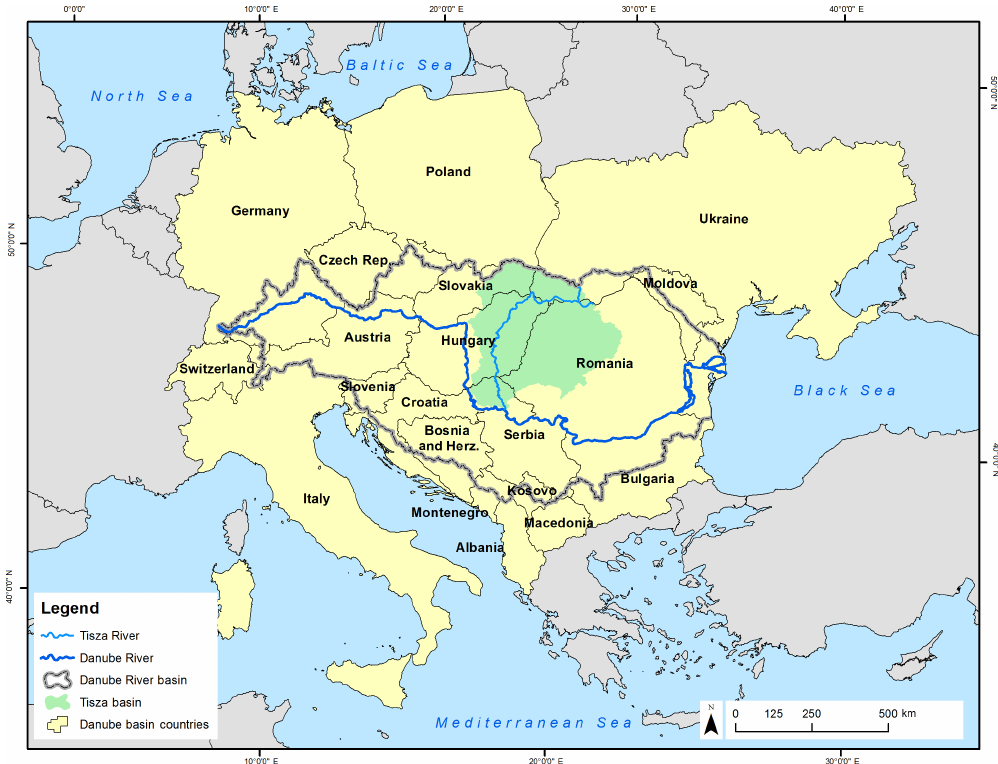
Figure 1. Map of Danube River basin and Tisza River sub-basin. Source: authors, using data from EUROSATA (2014), ICPDR (2013), and Lehner et al.